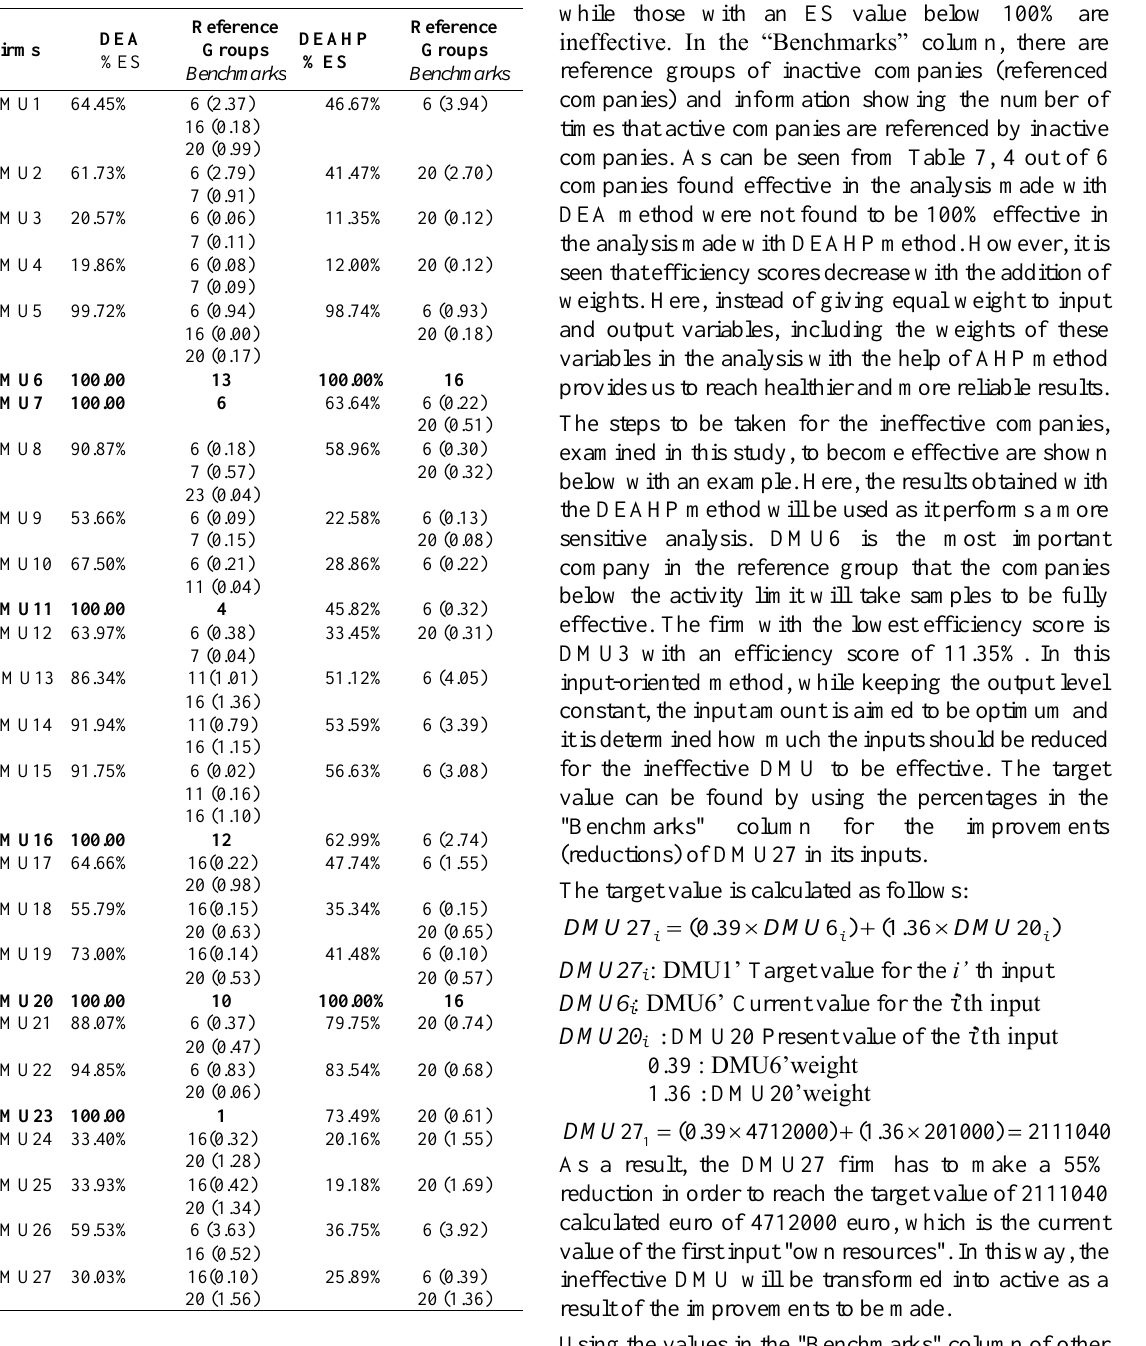
Table 7 . Efficiency scores and reference